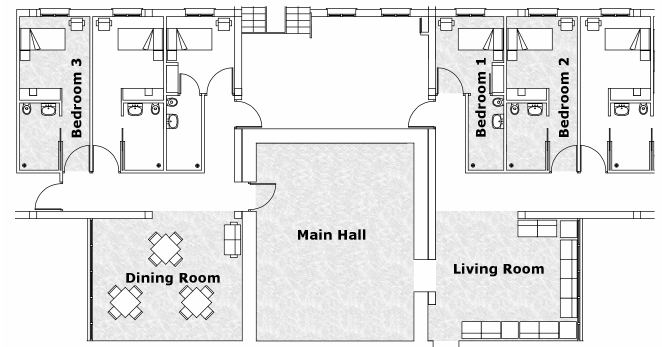
Figure 2. Area of interest: A cohabitation unit in the psychogeriatric ward of an elderly care